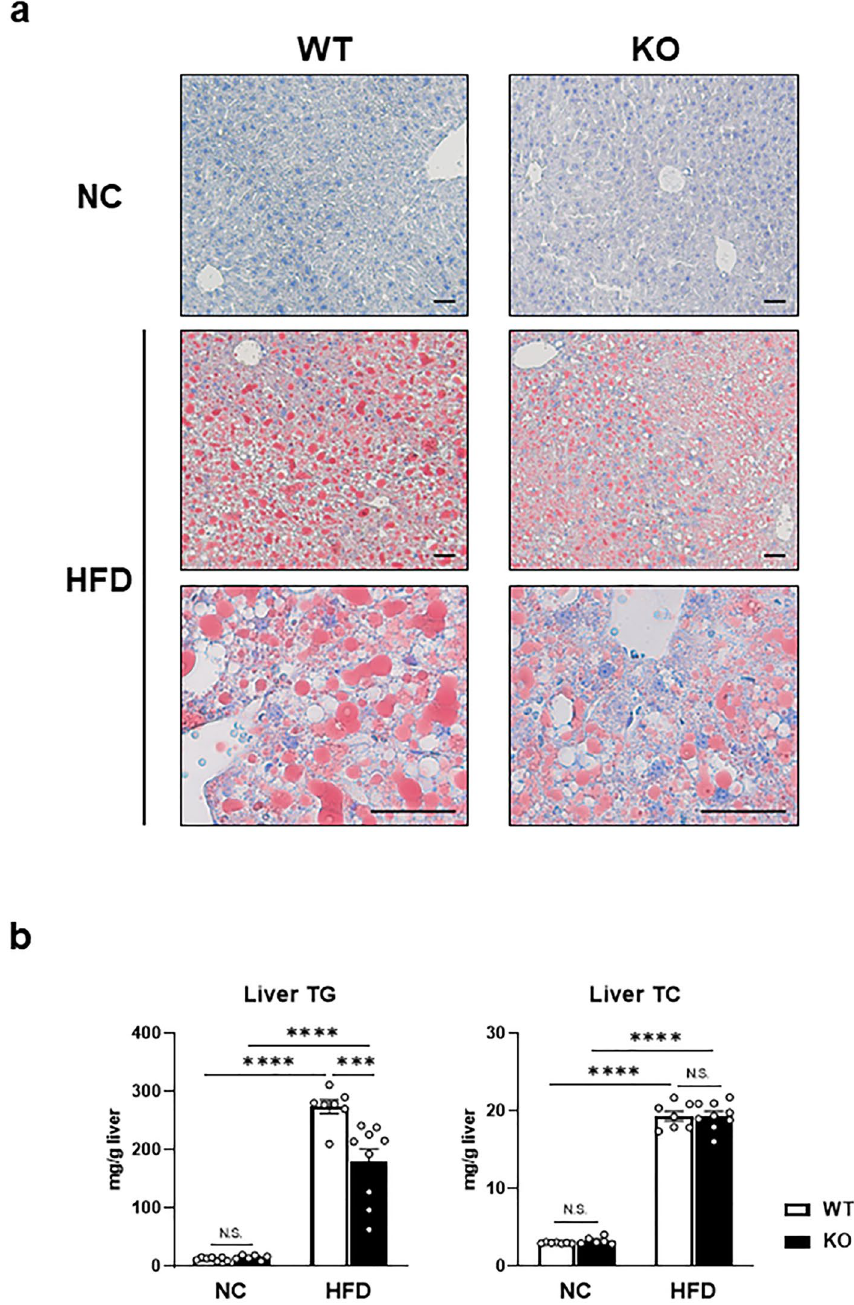
Figure 3. HFD-induced hepatic lipid accumulation was attenuated in FD-KO mice. (a) Images of Oil Red O staining for liver sections of WT mice or FD-KO mice fed NC or HFD for 17 weeks. Bars, 50 μm. The magnification of objective was ×10 in upper and middle images, and was ×40 in lower images. ( b ) TG or TC contents in liver of WT mice or FD-KO mice fed NC or HFD for 17 weeks. N = 7, 6, 7, 9. *** p < 0.001, **** p < 0.0001 by one-way ANOVA followed by a Tukey’s post-hoc